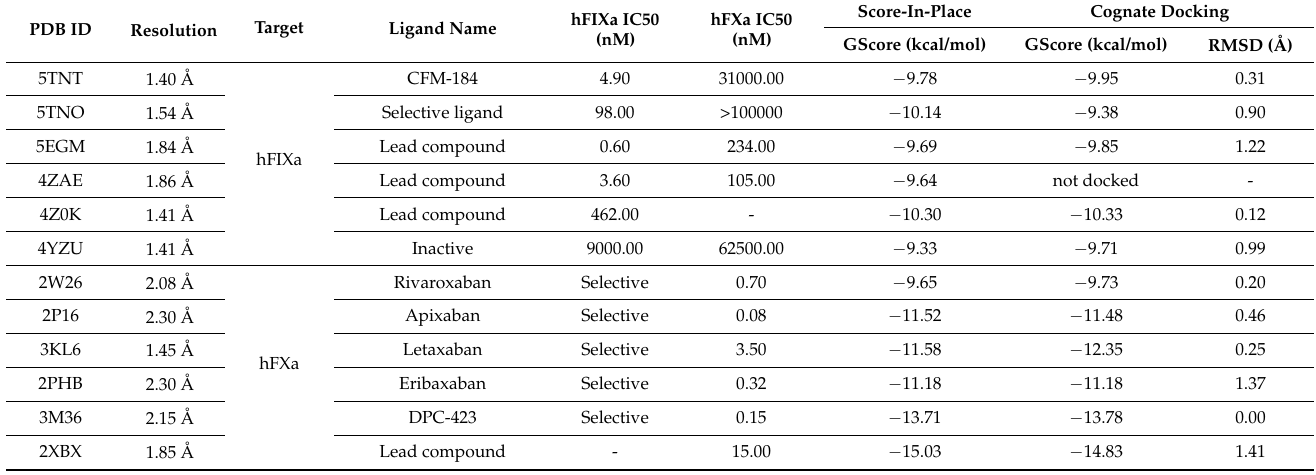
Table 4. The co-crystallized structures of protein–ligand complexes used in this work with their IC 50 values, reference binding scores, reference binding energies, cognate docking scores and the corresponding RMSD values. PDB ID